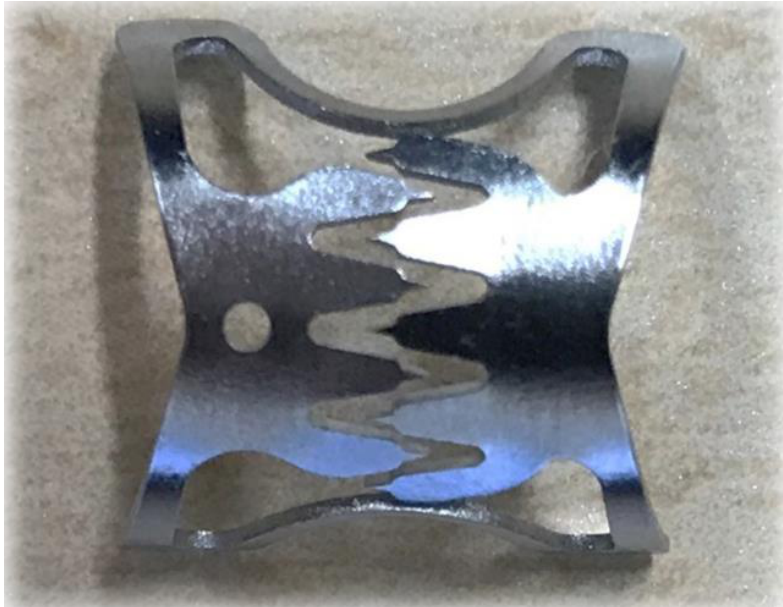
Figure 1. The structure of an over-the-scope clip (OTSC).